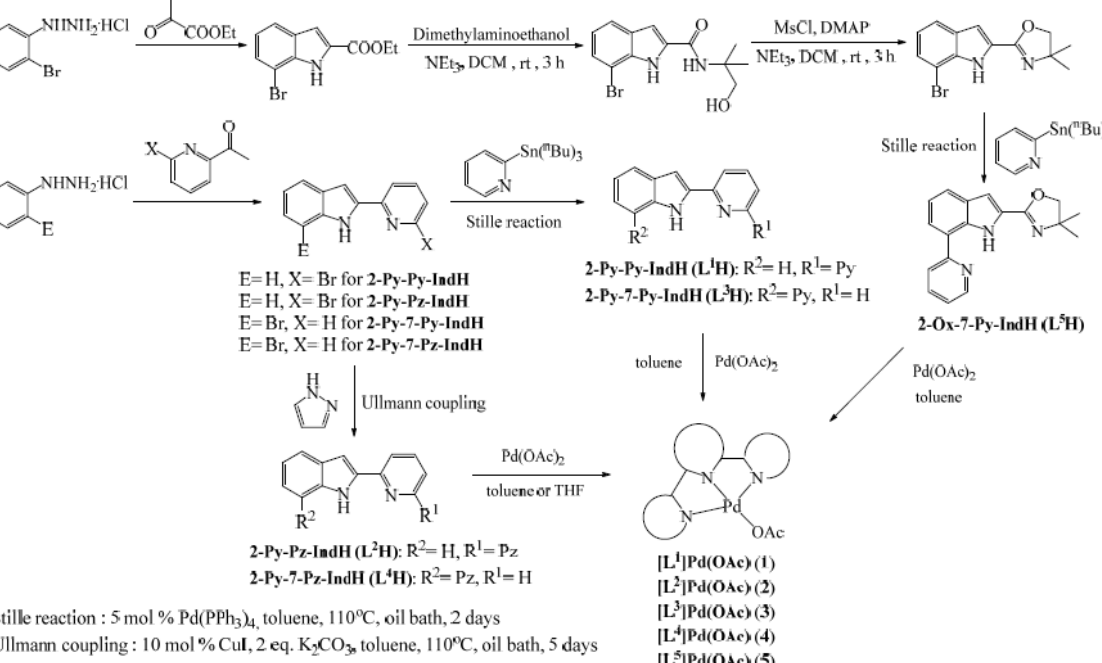
Scheme 1. Preparation of ligand precursors and palladium complexes.